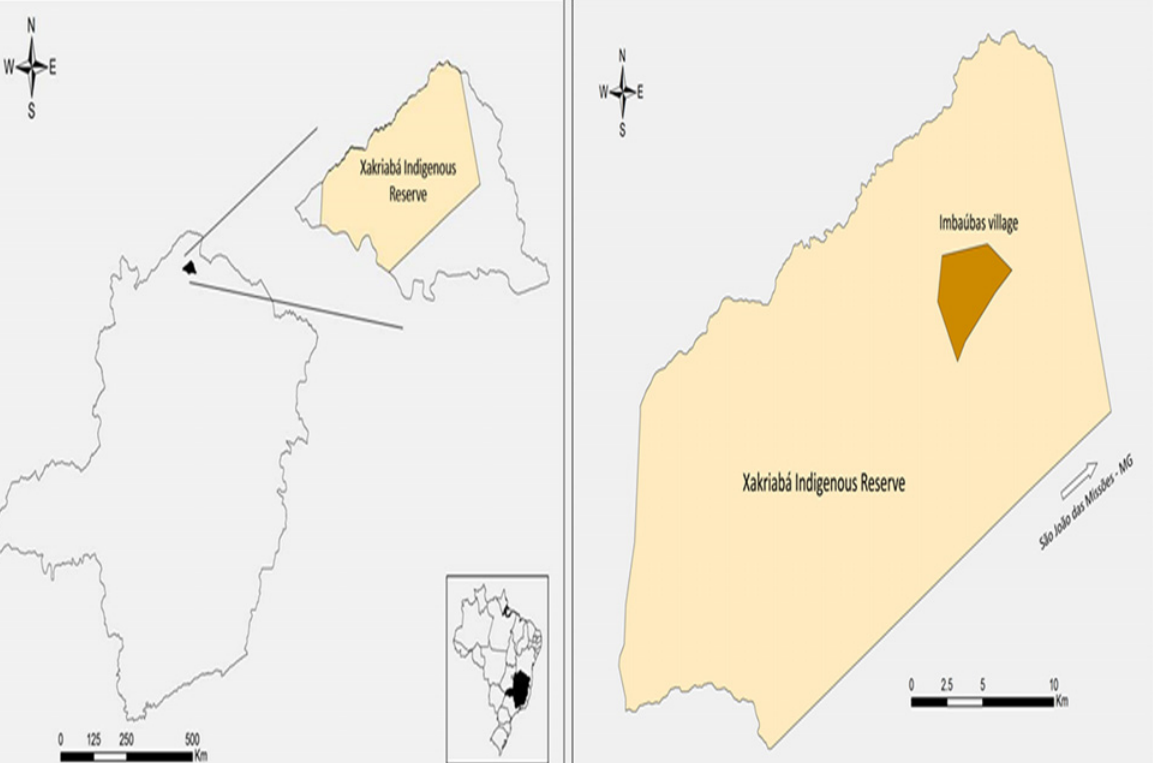
Fig 1. Location of study area. The location of the municipality of S ã o Jo ã o das Miss õ es in northern Minas Gerais, Brazil. The native village of Imbaúbas located in the Xakriabá Indigenous Reserve, where the study was performed, is indicated.